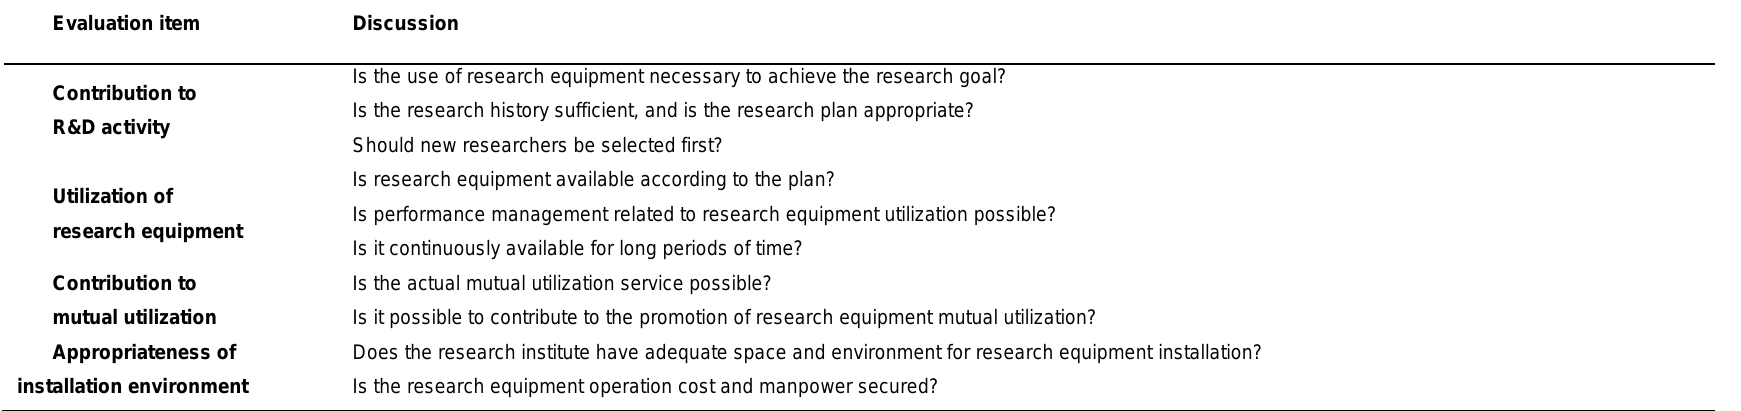
Table 19. Discussion for relocation of research